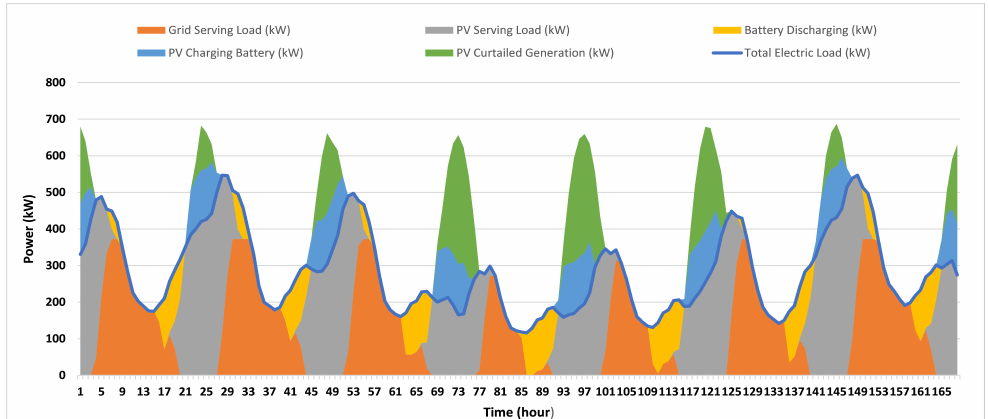
Figure 18. Microgrid operation during a week in the rainy season: Case 3, Scenario 1.